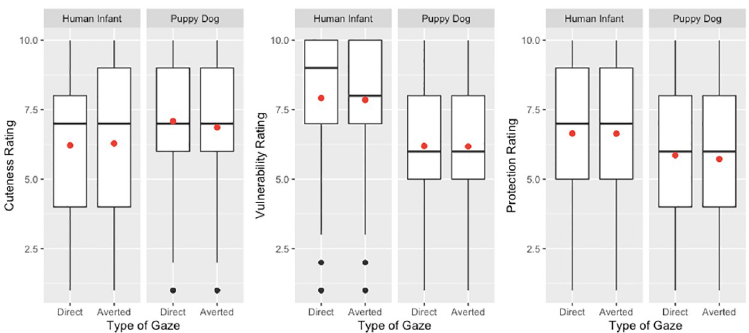
Fig 4. Experiments 4 and 5: Boxplots depicting ratings of human infants and puppy dogs, as a function of whether their eye gaze was direct or averted in Experiments 4 to 5. The boxplots describe data combined across both experiments. Boxes indicate interquartile ranges. Bold horizontal lines indicate medians. Red dots indicated means. Black dots indicate outliers.